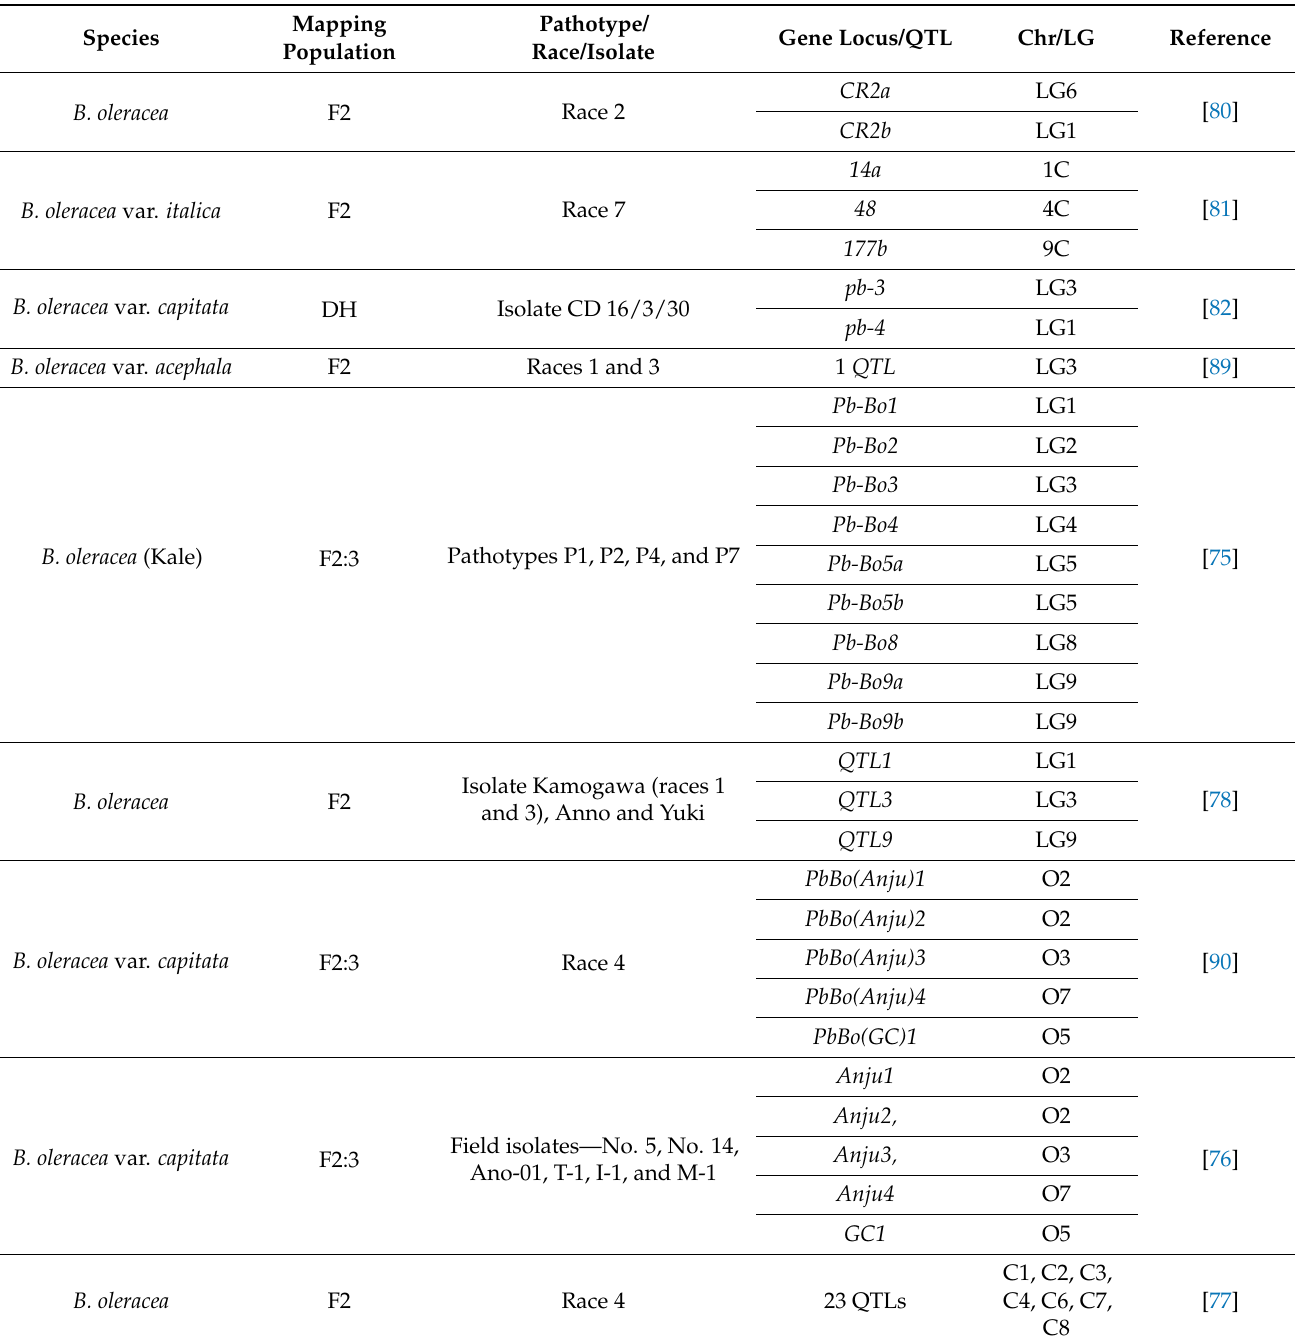
Table 1. List of QTLs associated with clubroot resistance in Brassica oleracea